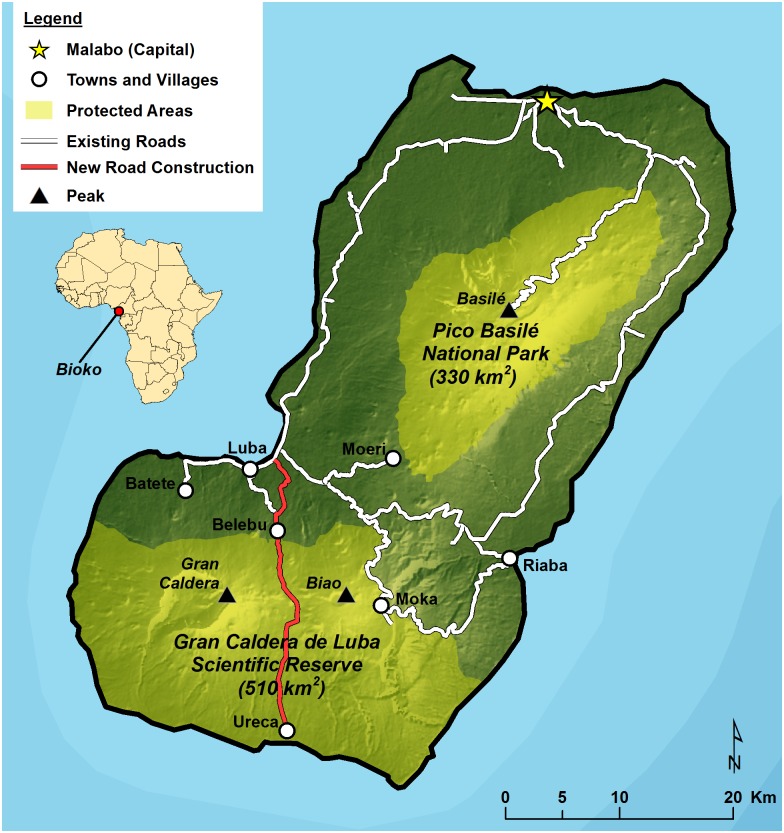
Distribution of major human settlements, main roads, and protected areas on Bioko Island.Also shown is Ureca, the only permanent human settlement entirely within a protected area on Bioko.